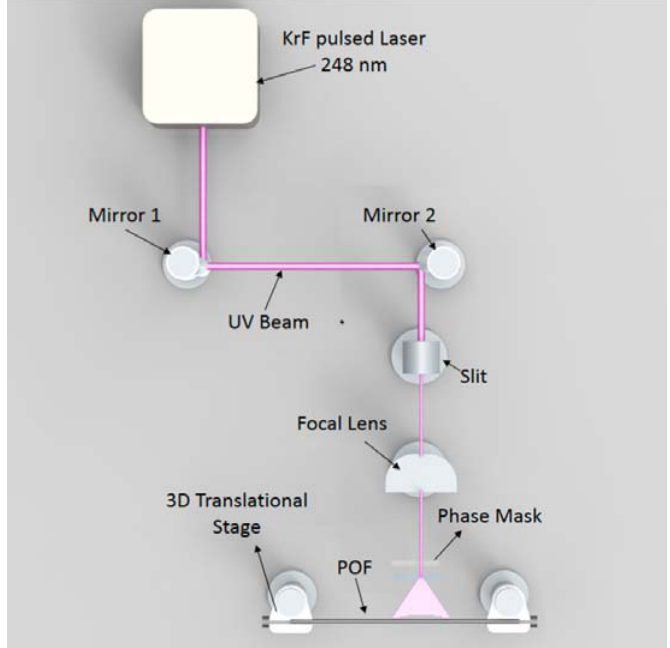
Figure 6. Schematic of phase mask inscription setup based on KrF pulsed laser for inscription of gratings on PMMA fibers, reported by Marques et al.; image from [70].